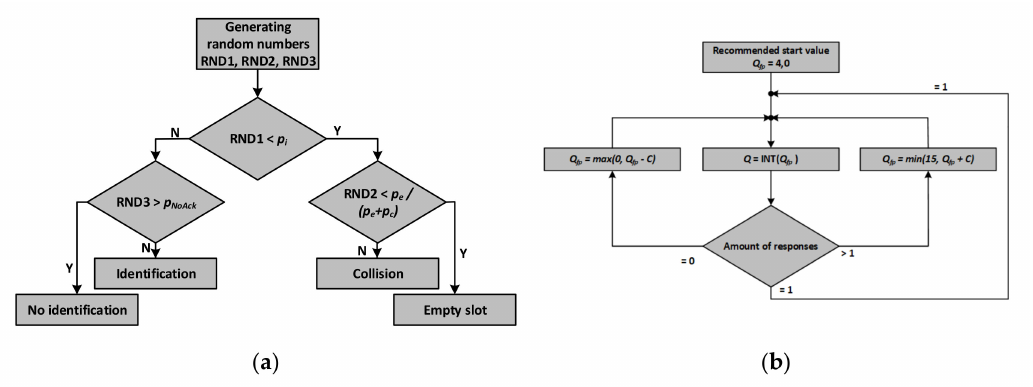
Figure 11. Procedures for estimating the occurrence of events in the inventory round: ( a ) algorithm of determination of events types in single slot; ( b ) The algorithm of the Q parameter determination